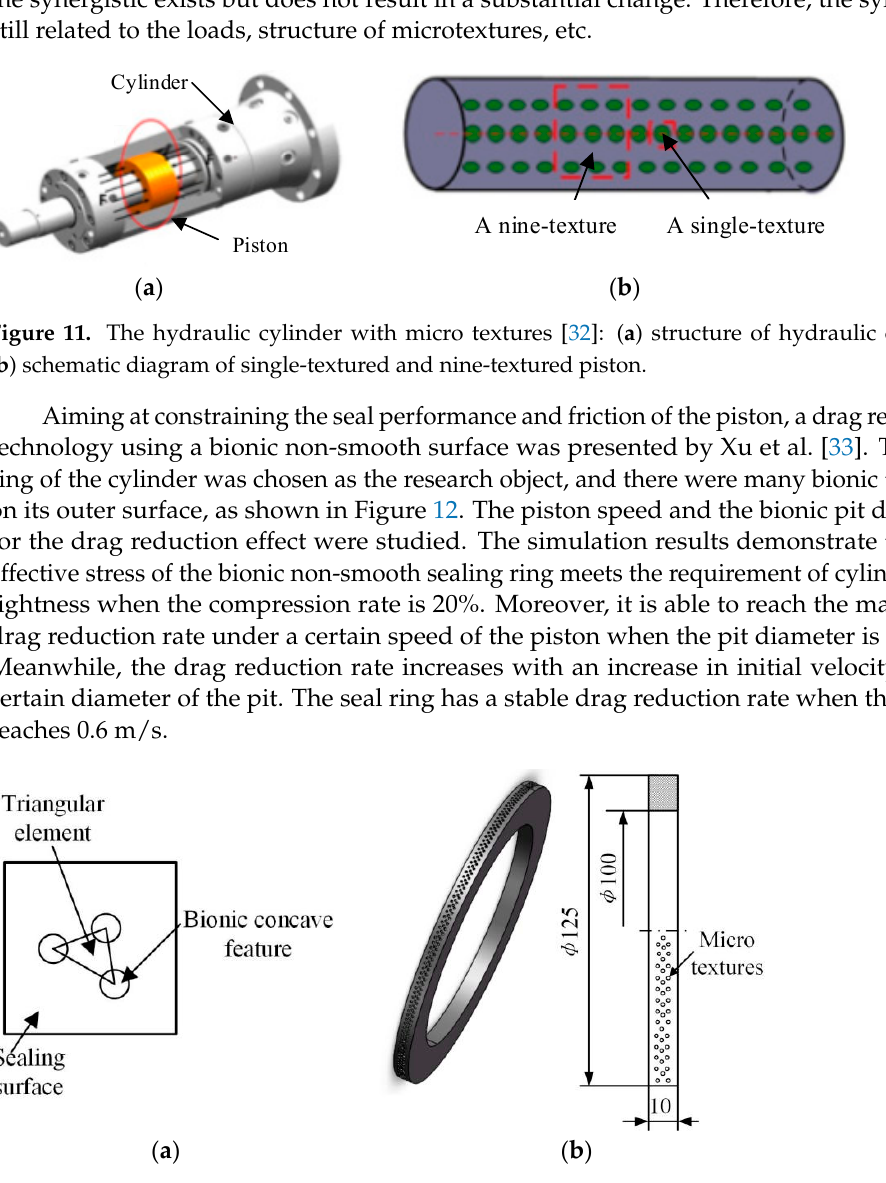
( b ) Figure 10. The hydraulic cylinder with diamond-like microtextures: ( a ) structure of hydraulic cyl- inder; ( b ) schematic diagram of a partially microtextured hydraulic cylinder . Zhang’s group [32] took the piston as the object and established single-textured and nine-textured models to compare and study their synergy based on the classical Reynolds equation, as shown in Figure 11. The simulation results reveal that the beneficial effect of the synergy firstly increases and then decreases as the area ratio of the texture increases.